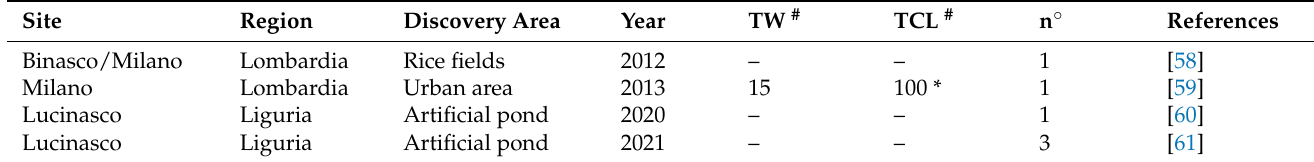
Table 1. Alligator snapping turtle ( Macrochelys temminckii ) reported in aquatic environments in Italy.